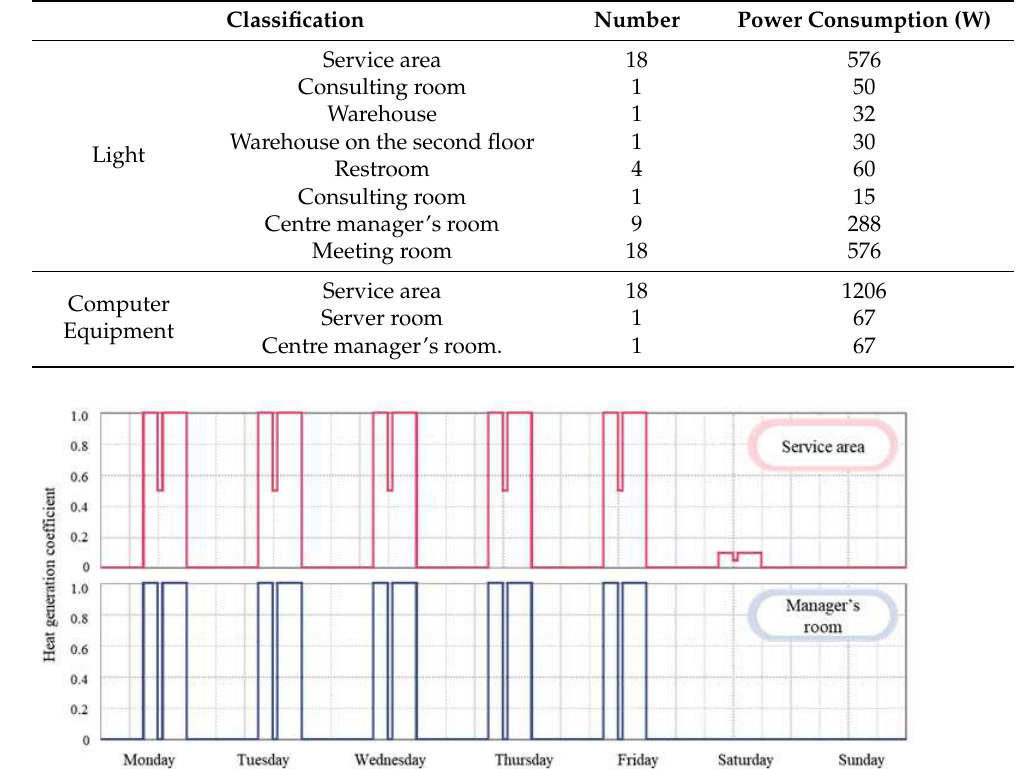
Figure 6. Occupant schedule in each space to consider the heat production by the